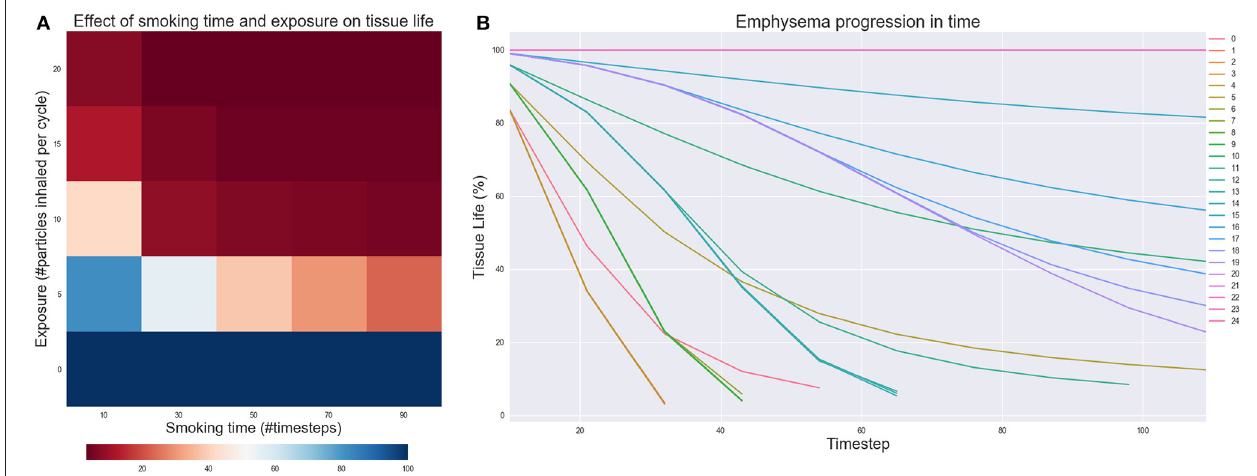
FIGURE 5 | (A) Effect of changing the number of particles inhaled for each simulated smoking (exposure) and the total time of the simulation spent smoking (Smoking time). The value of each cell is the residual tissue life in % after the simulation stopped. (B) Emphysema progression in time. The parameters of the experiments are in figure (A) : starting from experiment 0 in the lowest left corner to experiment 24 in the upper right.